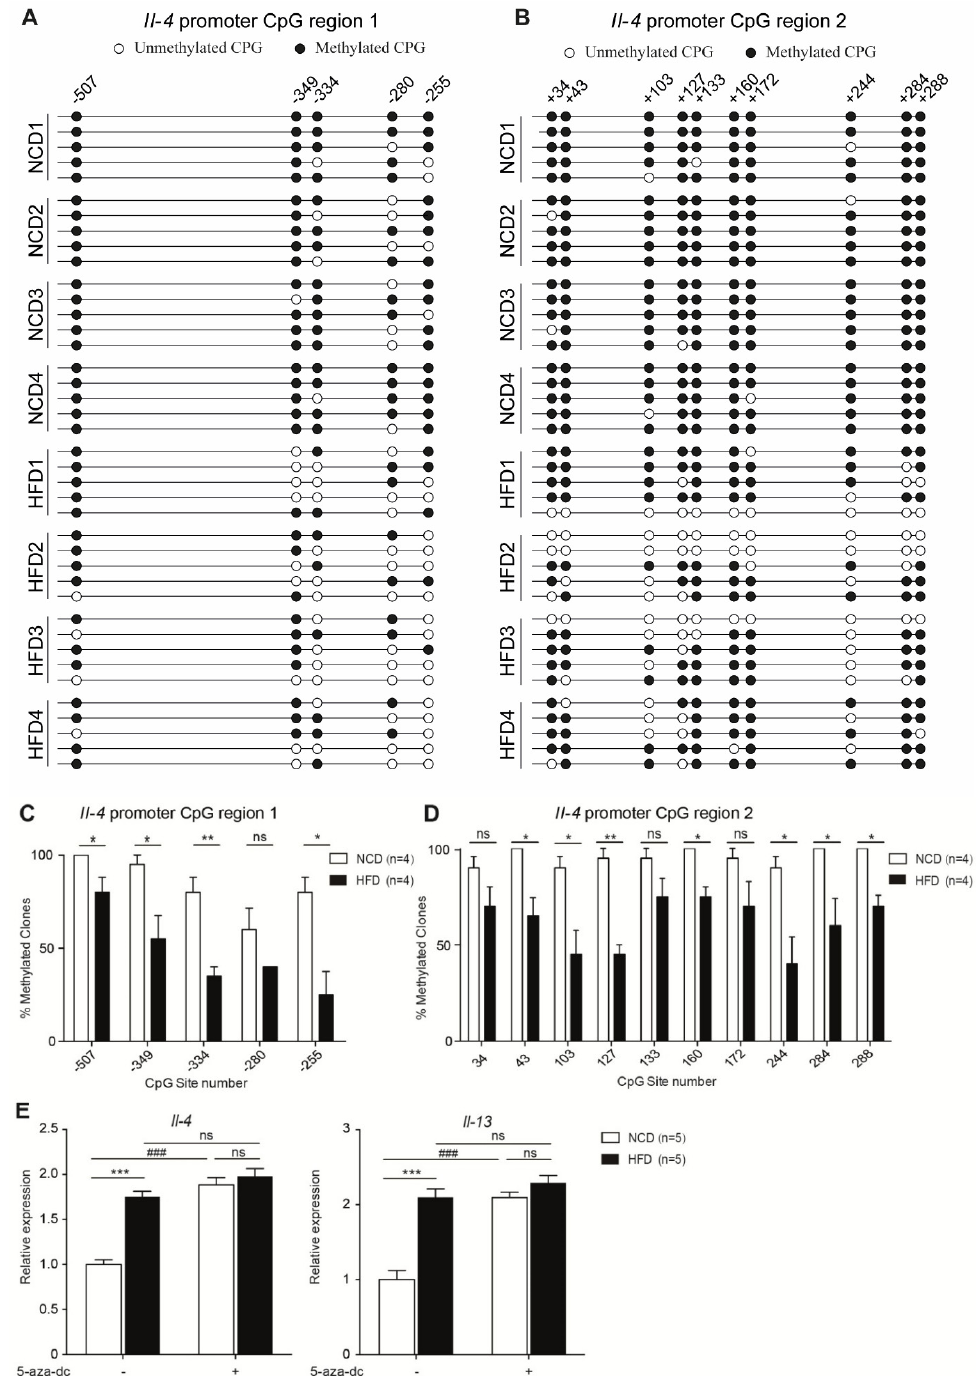
Figure 4. Maternal high-fat diet during pregnancy resulted in hypomethylation of Il-4 promoter region. Naïve CD4 + T-cells were assessed for Il-4 promoter region methylation level via bisulfite sequencing ( A – D ). Representative data and quantifications of methylation at CpG sites of the Il-4 promoter region 1 ( A , C ) and Il-4 promoter region 2 ( B , D ) in naïve CD4 + T-cells are shown. CD4 + T cells were stimulated with anti-CD3/anti-CD28 for 3 h in the presence of 5-aza-2 (cid:48) -deoxycytidine. The levels of Il-4 and Il-13 mRNA expression were analyzed by Real-time PCR analysis ( E ). p values were determined by using Student’s t -test ( A – D ) or one-way ANOVA with Tukey multiple comparisons p value correction ( E ). Data are shown as means ± SEM. n , Number of mice in each group. * p < 0.05, ** p < 0.01, *** p < 0.001, HFD versus NCD. ### p < 0.001, 5-aza-2 (cid:48) -deoxycytidine versus PBS. ns , not